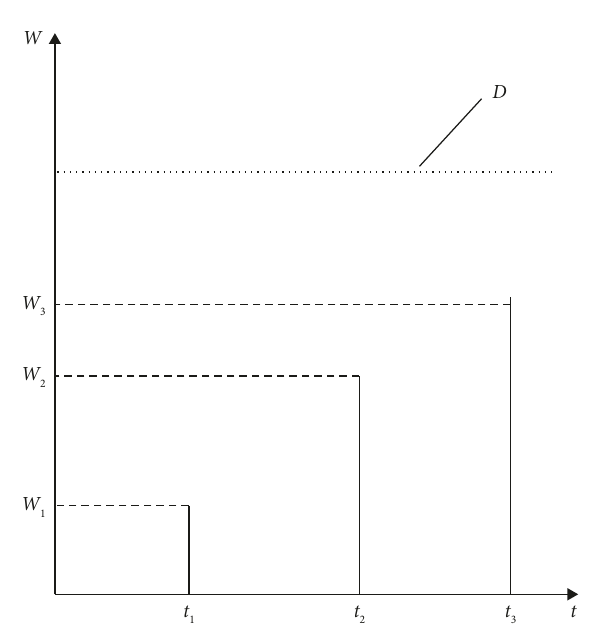
Figure 1: Soft failure process.